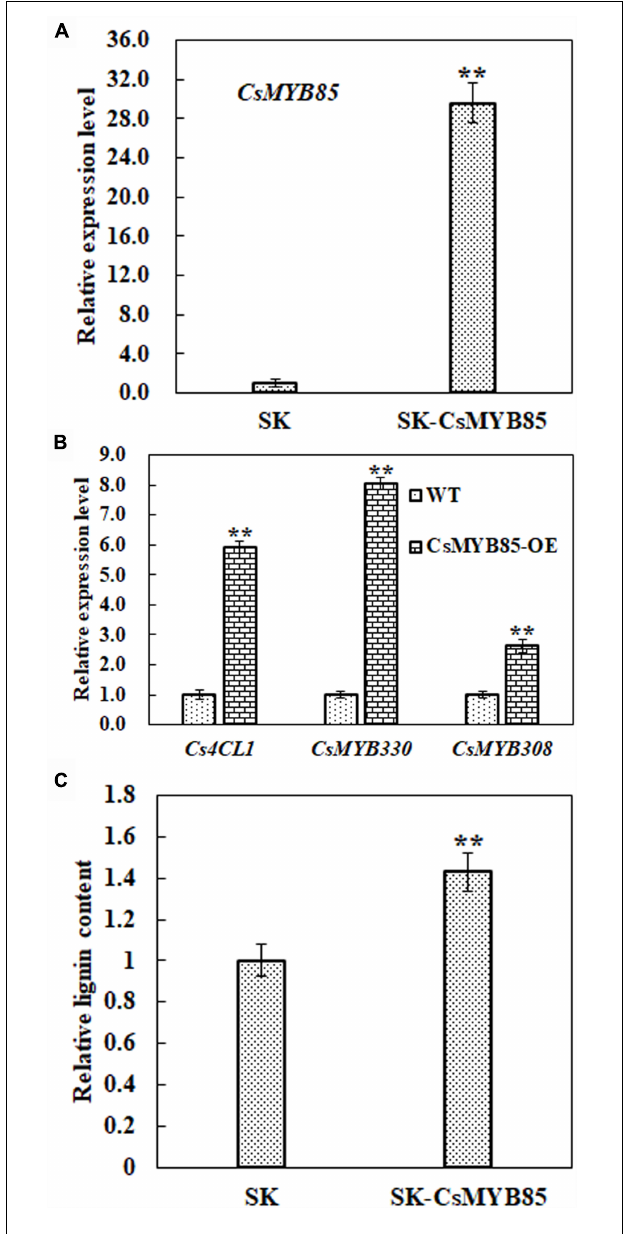
FIGURE 7 | Lignin content and gene expression analyses in transiently overexpressing juice sacs. (A) Expression levels of the CsMYB85 gene in transiently overexpressing juice sac tissues were determined using real-time qRT-PCR. Empty SK vector was used as a control. The CsMYB85 expression level was set to 1 in the cintrol. Expression of the CsActin reference gene ( NW_006256915.1 ) was used to normalize the CsMYB85 expression level. Error bars represent the standard error of four biological replicates. Student’s t -test: ∗∗ P < 0.01. (B) Transcription levels of CsMYB330 , CsMYB308 , and Cs4CL1 ( NW_006257196.1 ) in transiently overexpressing juice sac tissues determined by real-time qRT-PCR and normalized to the CsActin reference gene. Expression levels of CsMYB330 , CsMYB308, and Cs4CL1 in the SK control were set to 1. Error bars represent the standard error of four biological replicates. Student’s t -test: ∗∗ P < 0.01. (C) Lignin content in juice sac tissues. Means represent the averages of three replicate lignin content determinations in transiently overexpressing juice sac tissues. Error bars represent standard errors. Student’s t -test: ∗∗ P <